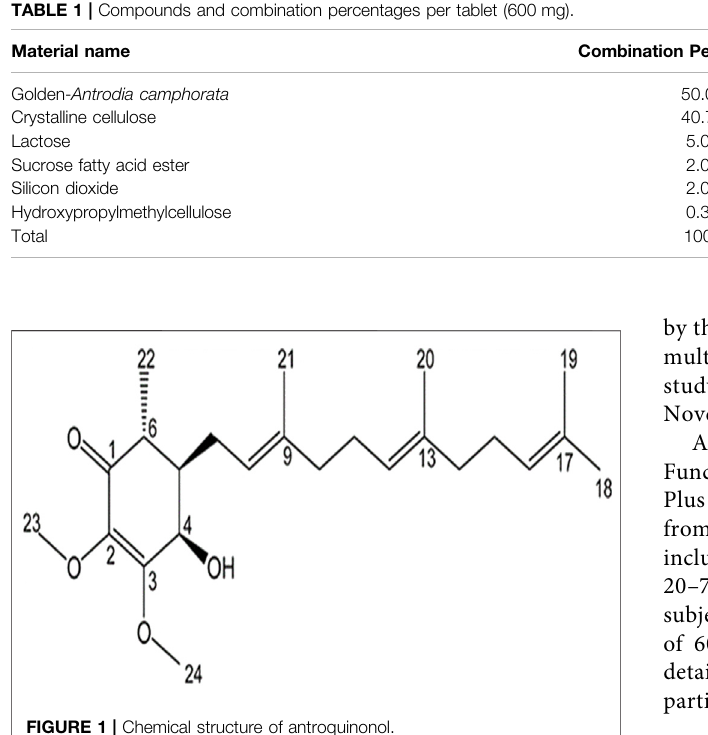
FIGURE 1 | Chemical structure of